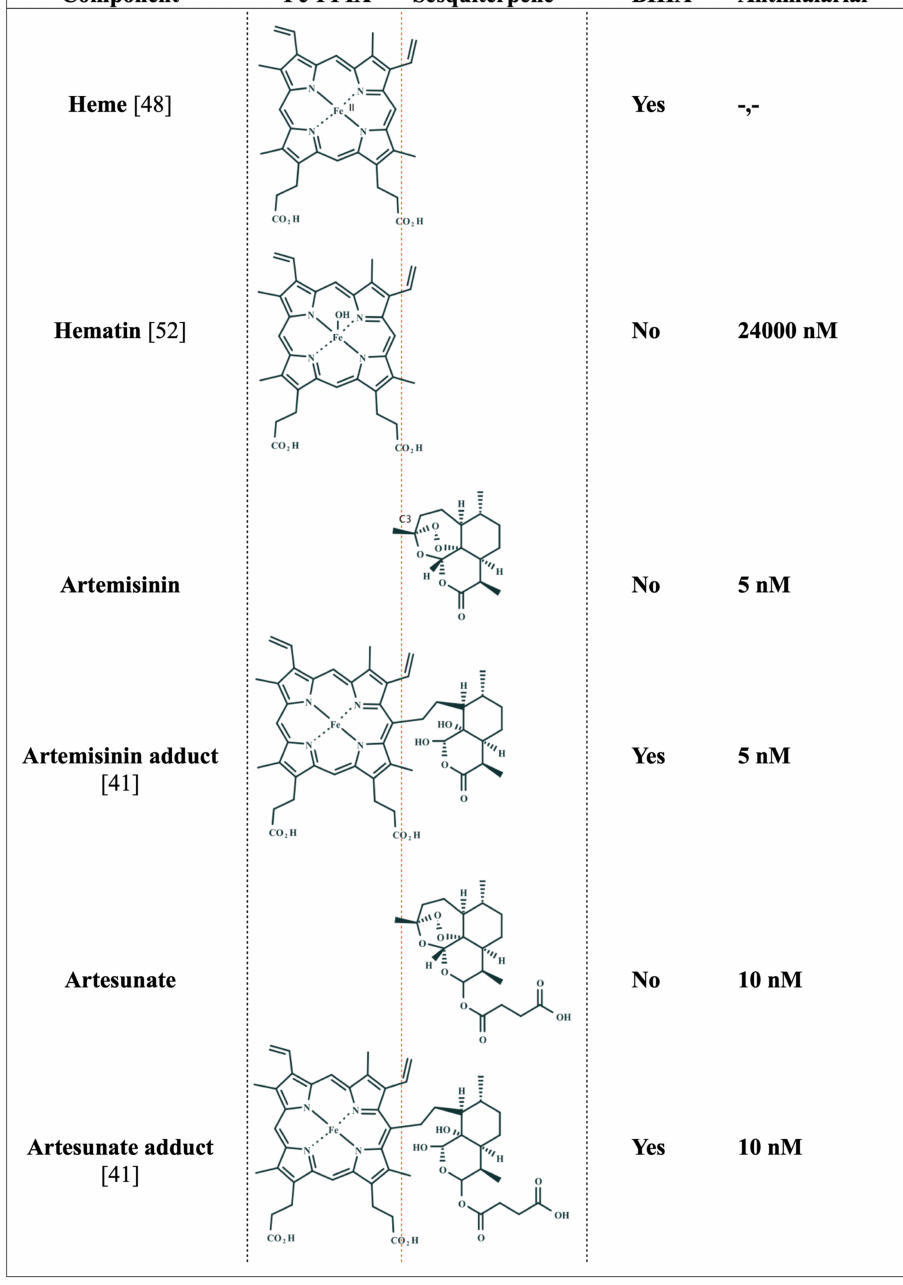
Figure 4. Structure–activity relationship of Fe-PPIX, sesquiterpenes, and their hematin–drug adducts. BHIA = β -hematin inhibitory activity. Yes indicates inhibitory activity; No indicates the absence of inhibitory activity. Antimalarial = IC 50 values of the in vitro antiparasitic activity against the asexual blood stages of P. falciparum . Adducts are drawn as deacetylated structures (indicated by C-3 carbon) according to reference